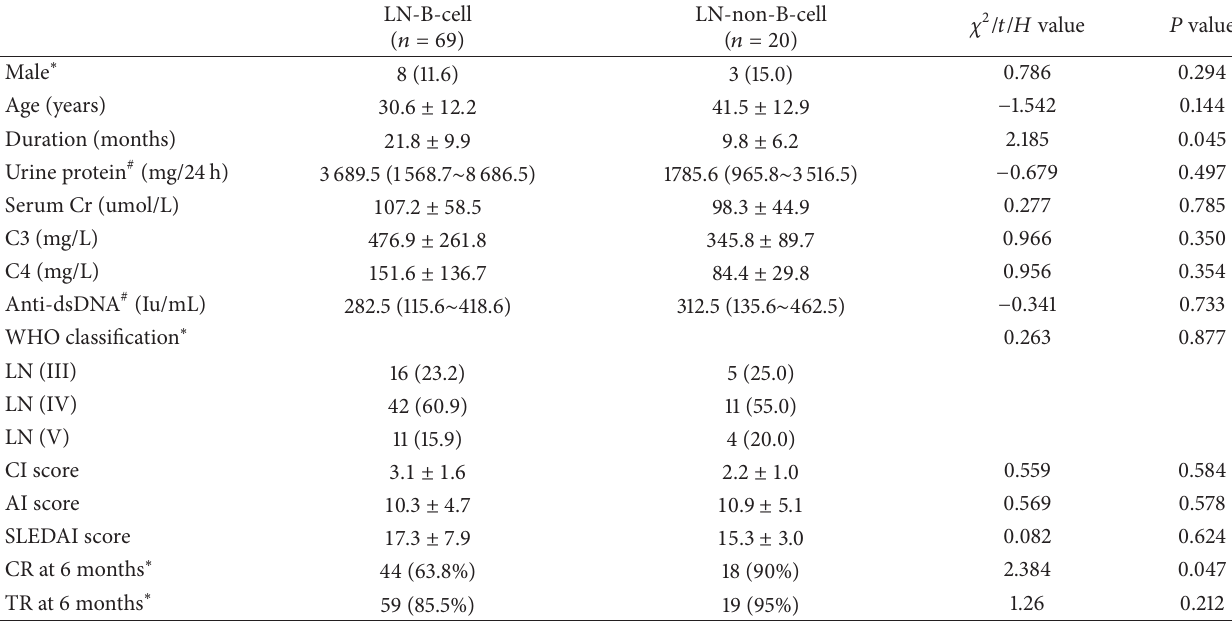
Table 1: Clinical data of the B-cell group and the non-B-cell group in LN patients.